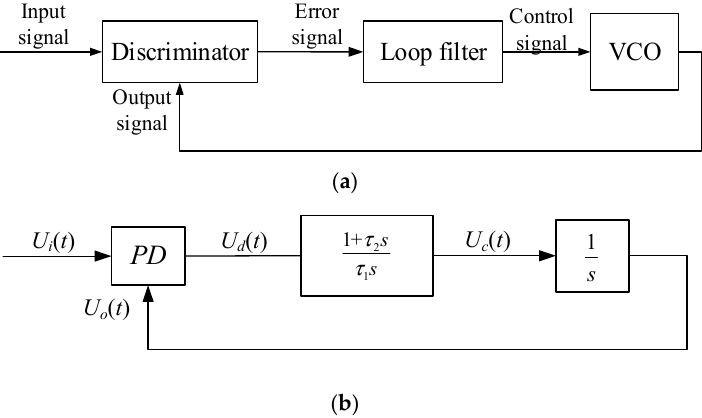
Figure 1. ( a ) Basic structure of the second-order phase-locked loop (PLL). ( b ) Model of the second-order